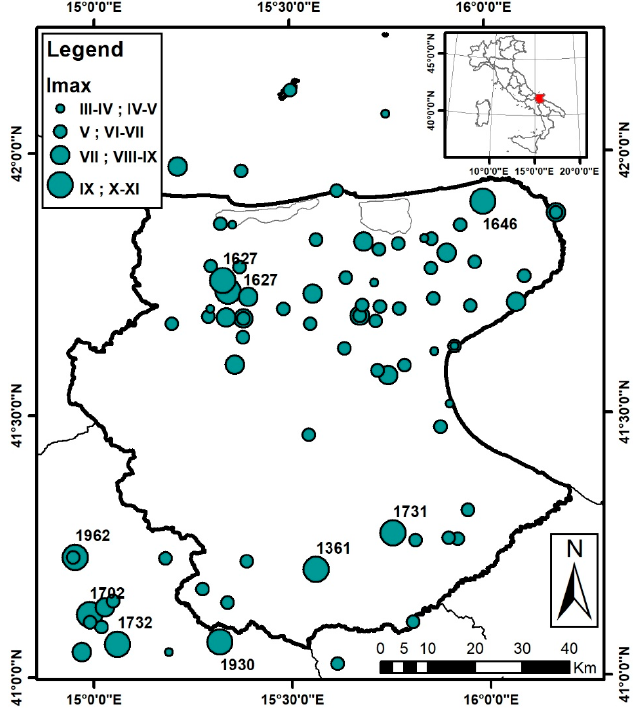
Figure 1. Dots represent epicenters of the main seismic events with maximum intensity (Imax) larger or equal to III-IV MCS that occurred in the study area and surroundings between 1000 and 2019 AD [11] (size is proportional to the relevant Imax value). The year of occurrence of the events characterized by Imax larger or equal to IX MCS is shown. The thick and thin black lines represent the border of the study area and the Italian regional administrative limits, respectively. The red area in the top right panel indicates the geographical position of the Northern Apulia area with respect to Italian territory. Geosciences 2021 , 11 , 416